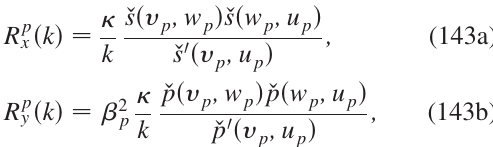
FIG. 10. Function R p y ð k Þ and the resonance points (cid:20) p m for p ¼ 0 . The symbols ( (cid:11) ) are the resonance points of the VE mode. The parameters are the same as Fig.